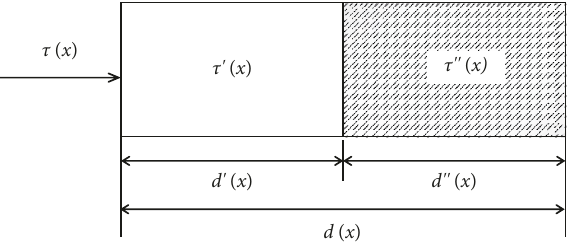
Figure 8: Micro-stress analysis of geogrid-soil